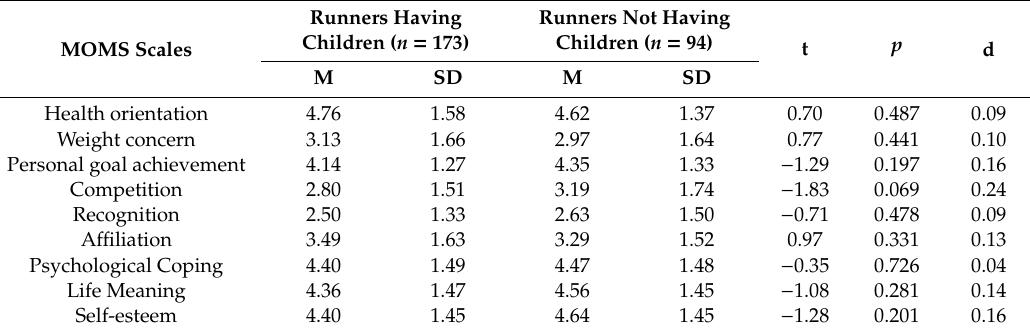
Table 5. Runners having children vs. runners not having children.